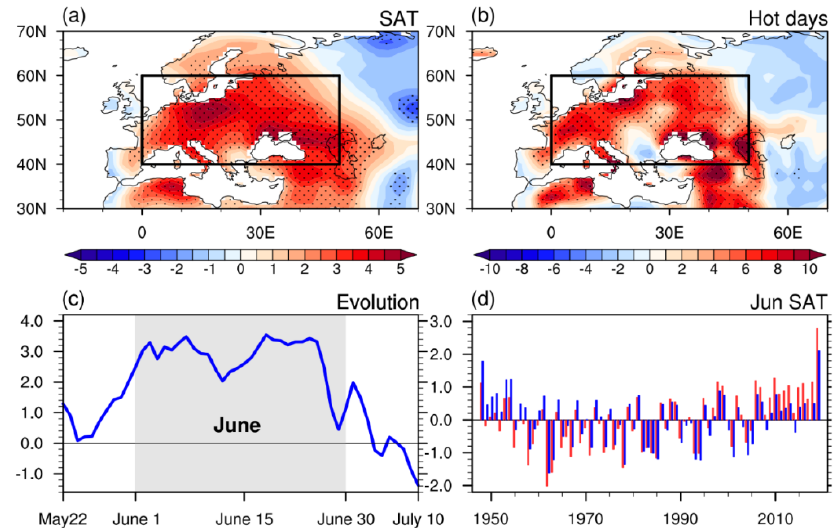
Figure 1. ( a ) Anomalies of surface air temperature (SAT) (unit: ◦ C) in June of 2019 relative to 1948–2019. ( b ) Anomalies of hot days in June of 2019 relative to 1948–2019. Hot days were identified when the surface maximum temperature of a day exceeded the 95% percentile. Stippling regions in ( a ) and ( b ) respectively represent SAT and hot day anomalies exceeding one standard deviation. Black boxes in ( a ) and ( b ) were employed to calculate region-mean SAT anomalies. ( c ) Evolution of daily SAT anomalies averaged over Europe (black box in ( a , b )) from 22nd May to 10th July in 2019. ( d ) Time series of SAT anomalies in June averaged over Europe (black box in ( a , b )) from 1948 to 2019 with (red bars) and without (blue bars) the linear trend.